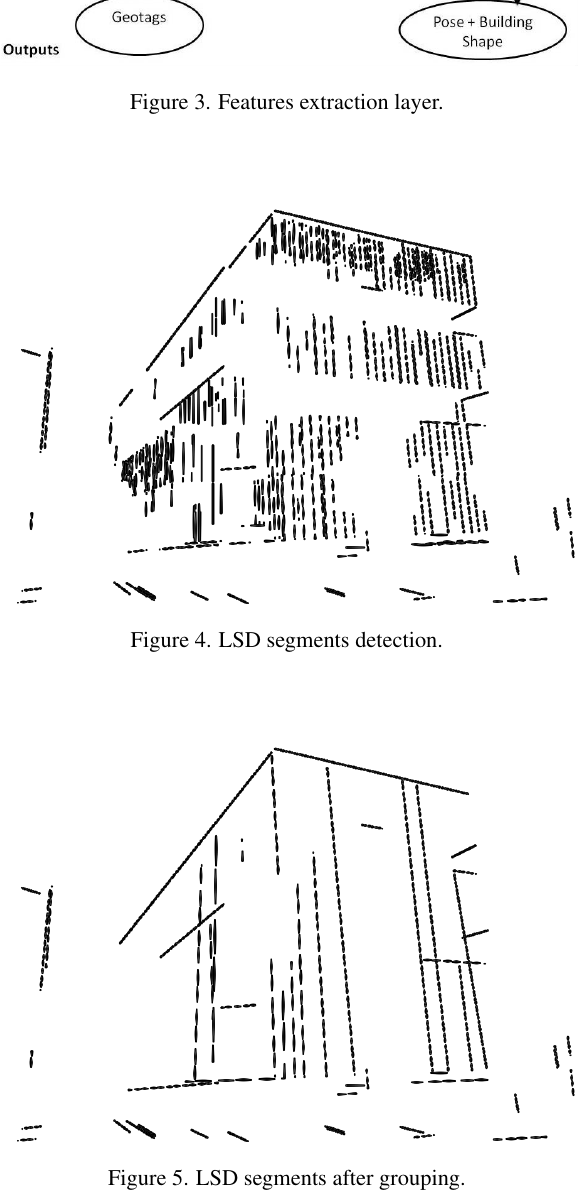
Figure 5. LSD segments after